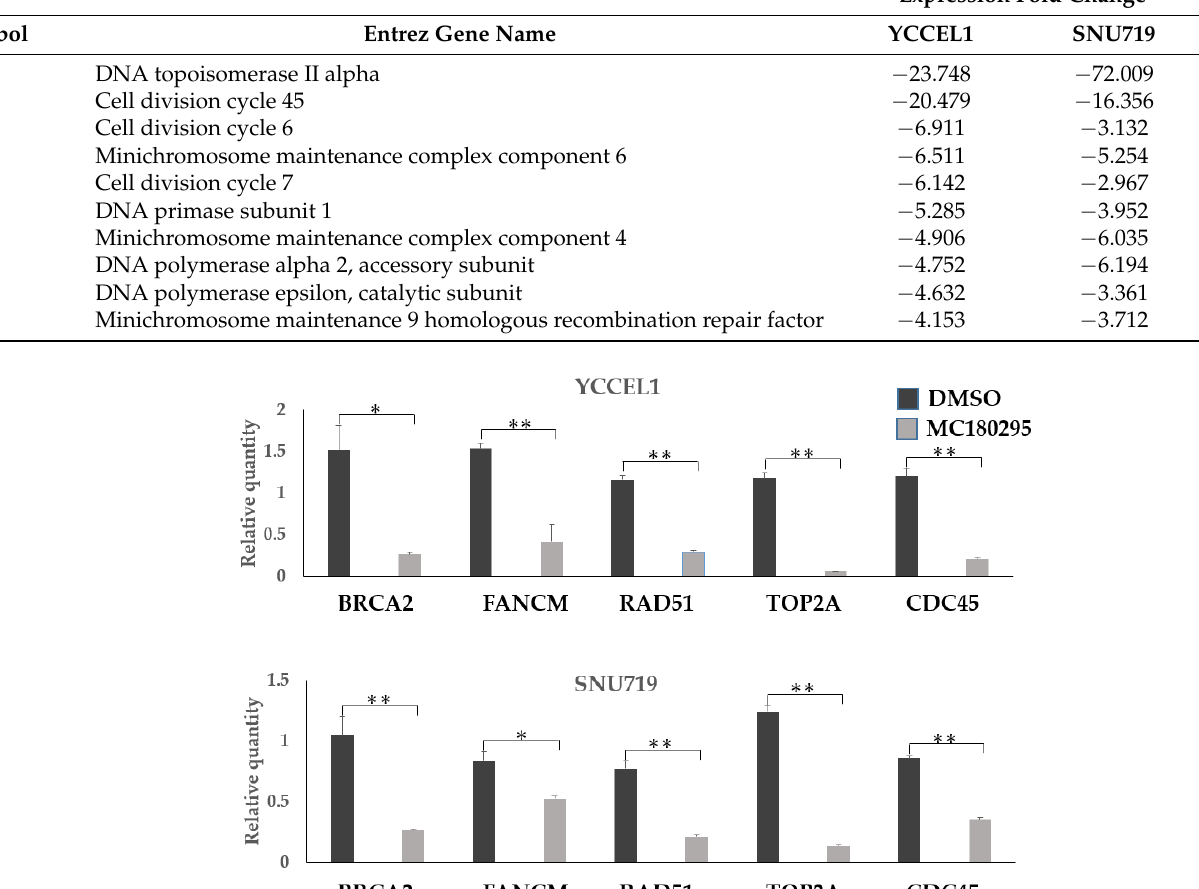
− 5.305 Table 2. Change of gene expression of pathway “cell cycle control of chromosomal replication”. Expression Fold Change Symbol